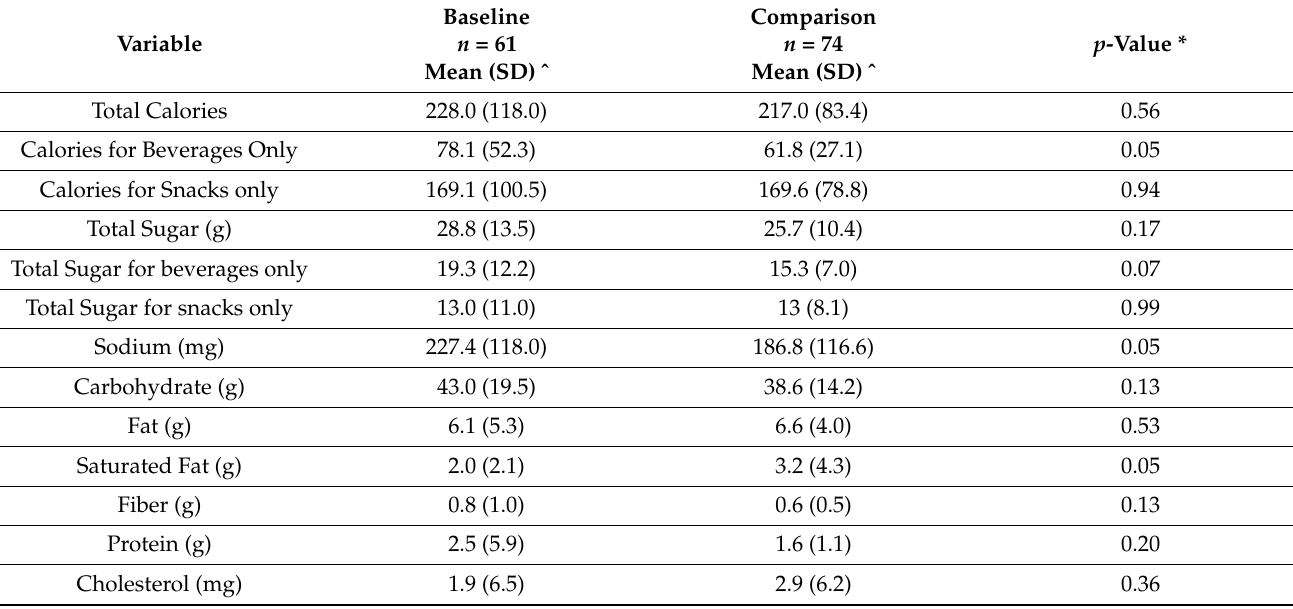
Table 1. Differences in nutritional outcomes per game between baseline intervention group and postintervention comparison group.